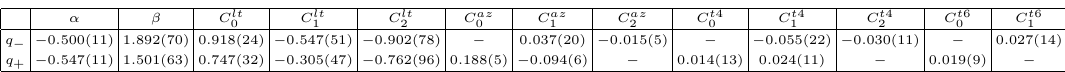
Table 3 . Fit parameters associated with the representative fits to Re Y shown in figure 5 and figure 8, respectively. The figures of merit for the fit to Re Y L 2 / d . o . f . = 0 . 265(131) and χ 2 / d . o . f = 0 . 280(126) , while L 2 / d . o . f . = 0 . 756(241) and χ 2 / d . o . f = 0 . 659(233) for Im Y